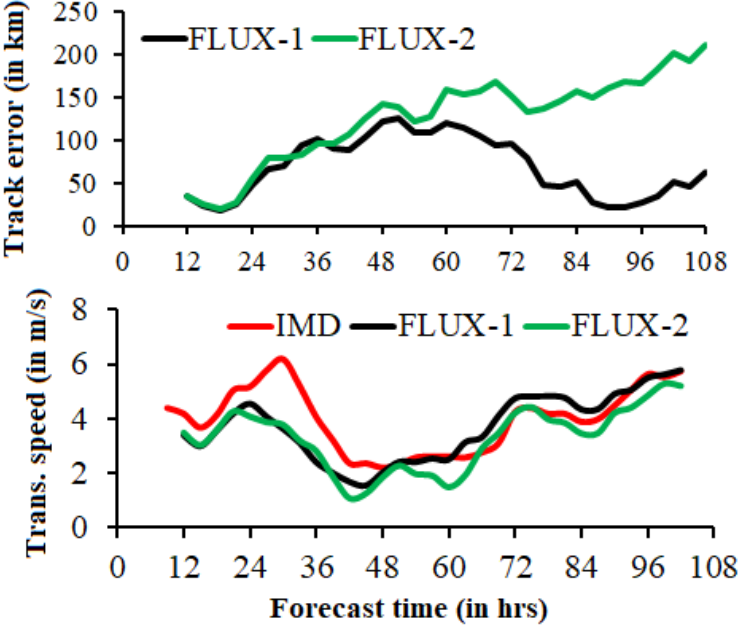
Figure 5. Model simulated track errors (in km) and translation speed (m/s) from simulations along with IMD best-fit track at every 3 h interval. with IMD best-fit track at every 3 h